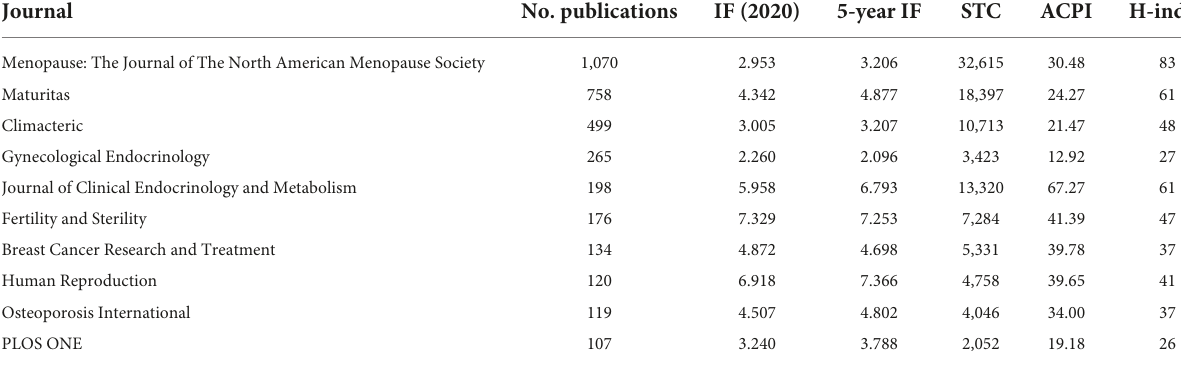
TABLE 1 Journals with more than 100 menopausal hormone therapy (MHT)-related publications ( N =